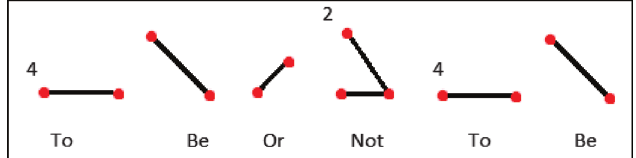
Figure 9. Pattern for “To Be Or Not To Be.”